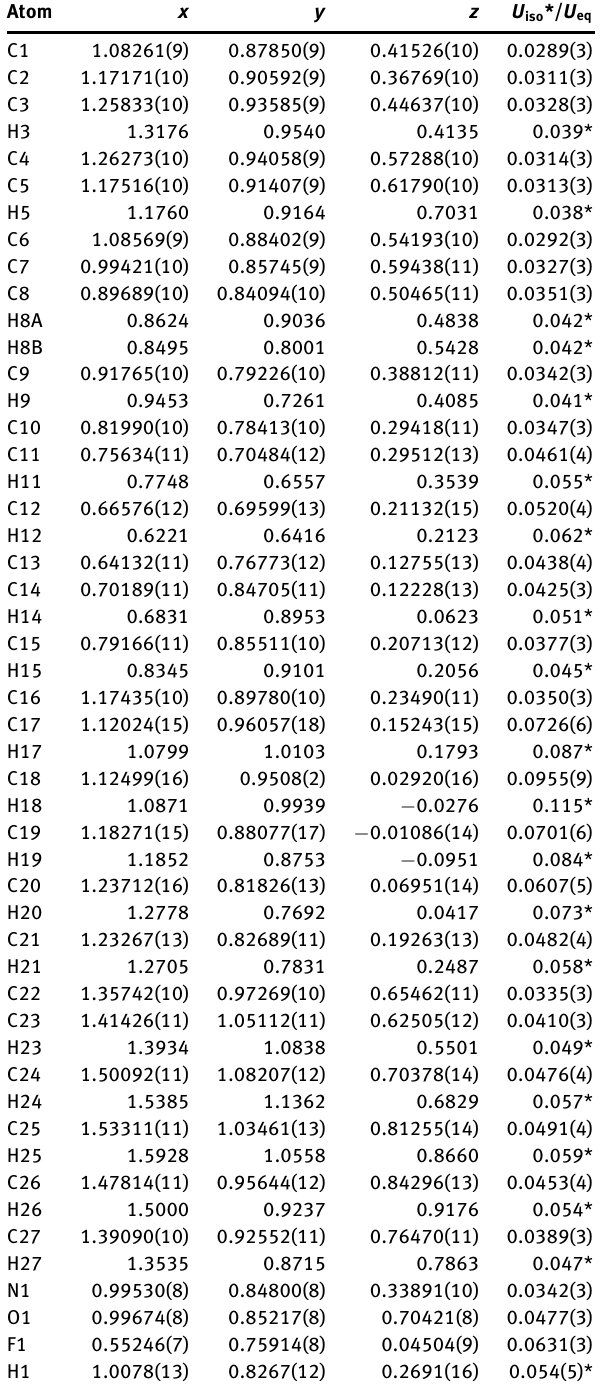
Table 2: Fractional atomic coordinates and isotropic or equivalent isotropic displacement parameters (Å 2